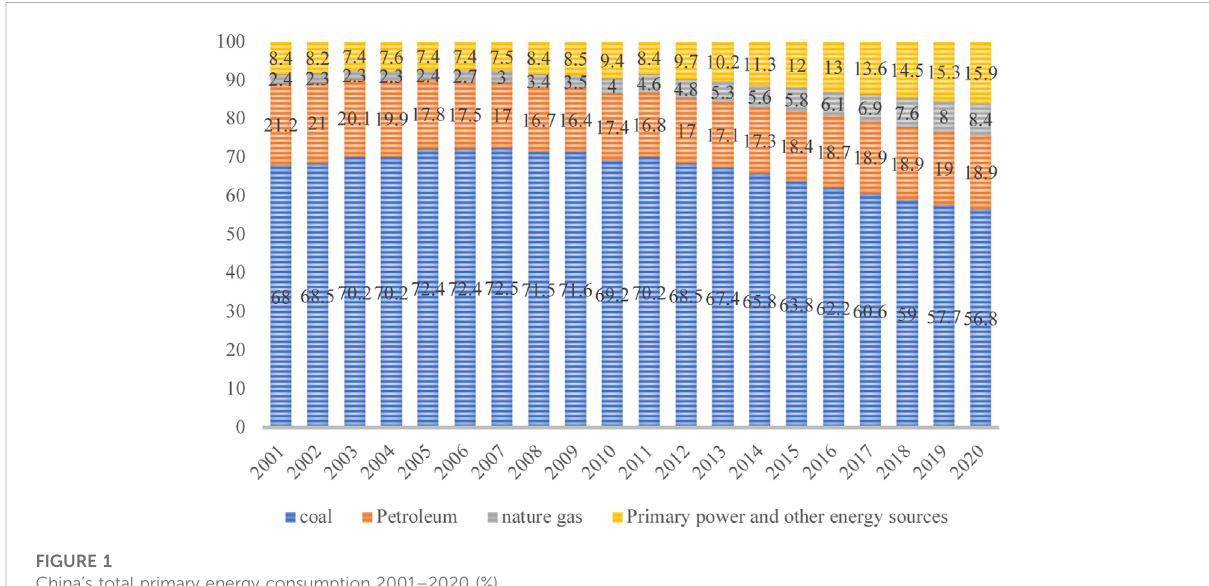
FIGURE 1 China ’ s total primary energy consumption 2001 – 2020